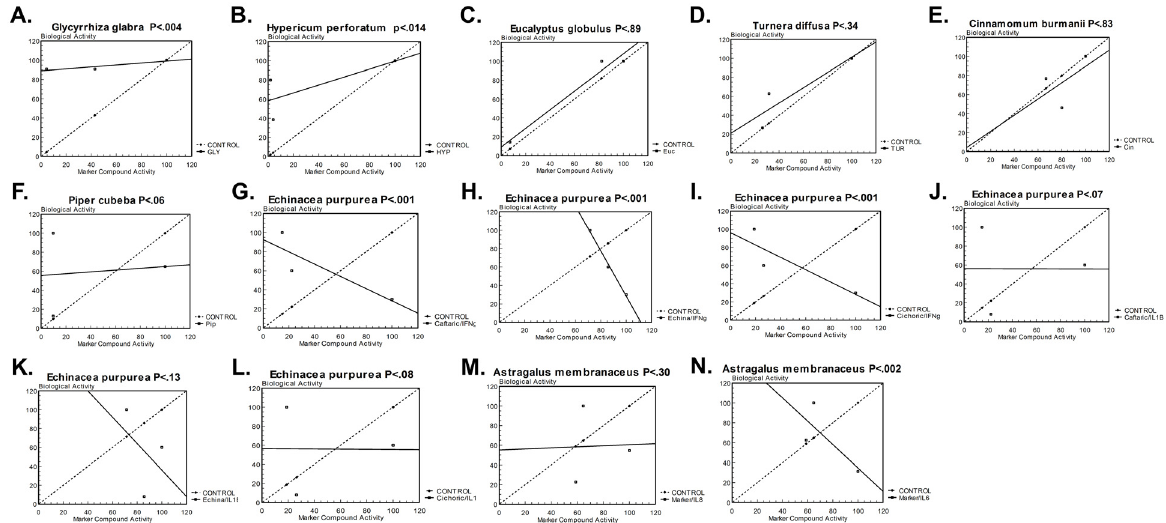
Fig 5. Regression analysis of marker compound level versus bioactivity. A regression line comparison (Co-Variance) between the marker compound level and bioactivity of each botanical is shown. A “ CONTROL ” regression line representing a 1:1 cause and effect relationship is shown for comparison. The p-value representing the statistical difference between the marker compound level and bioactivity is shown.